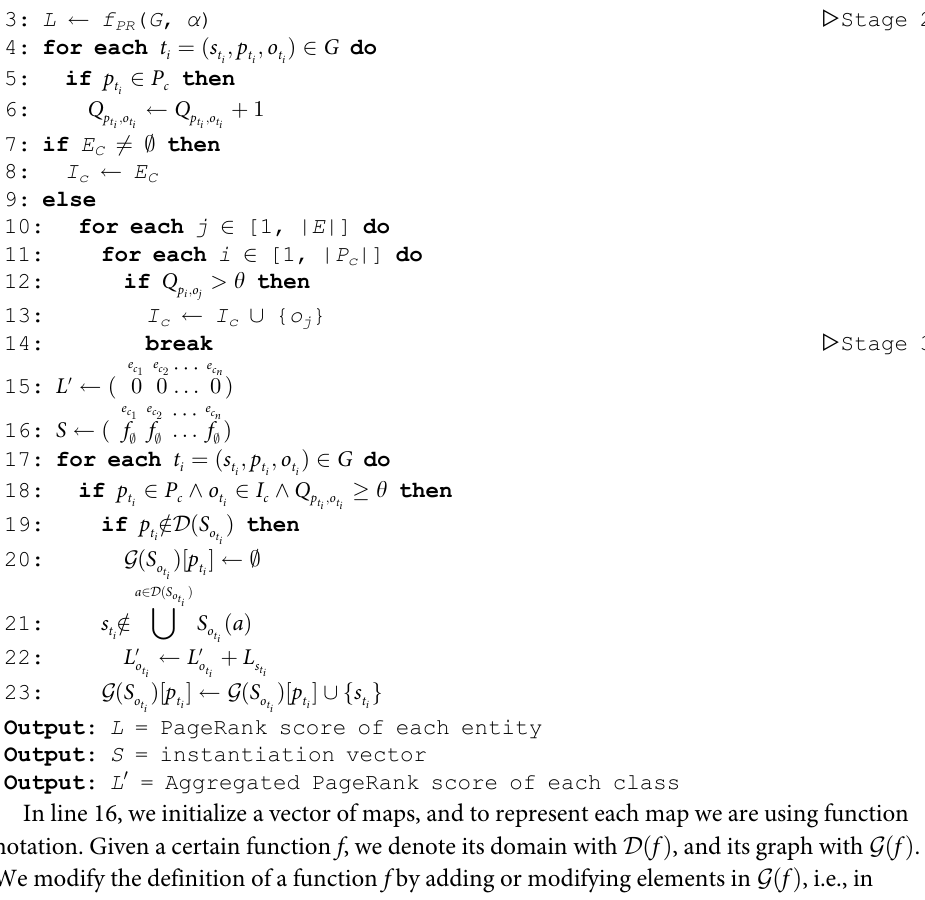
of class-pointers, a damping factor C